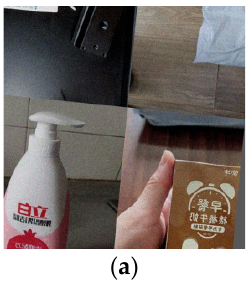
Figure 4. The effects of data augmentation: ( a ) traditional + mosaic; ( b ) traditional + mixup; ( c ) mosaic + mixup; ( d ) traditional + mosaic + mixup.